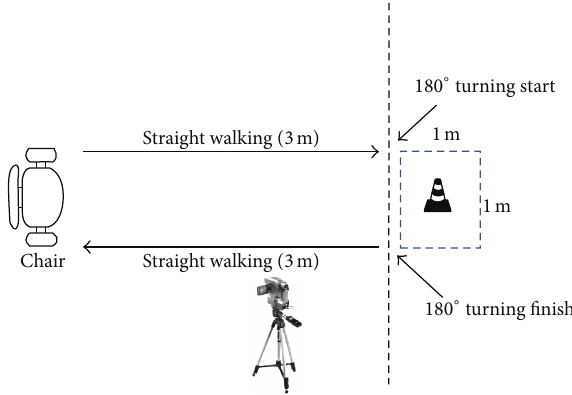
Figure 1: Diagrammatic presentation of Timed Up and Go